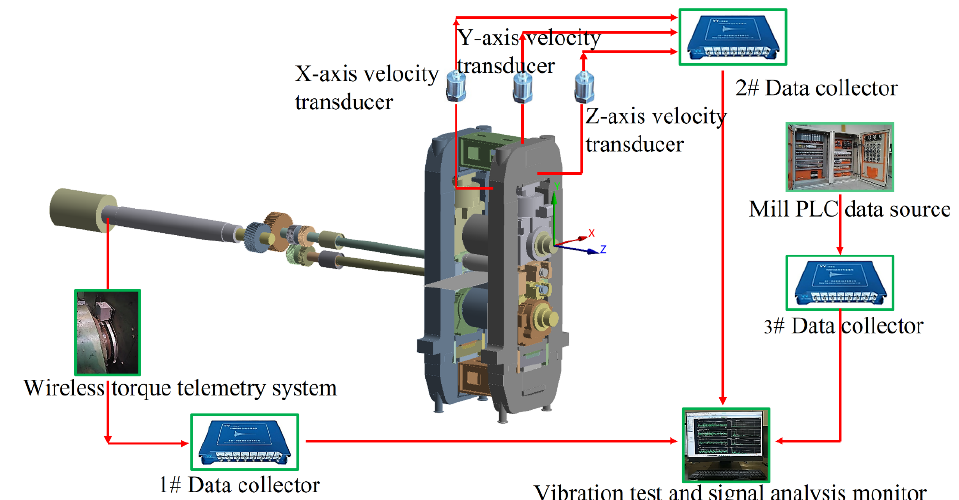
Figure 5. Test during rolling